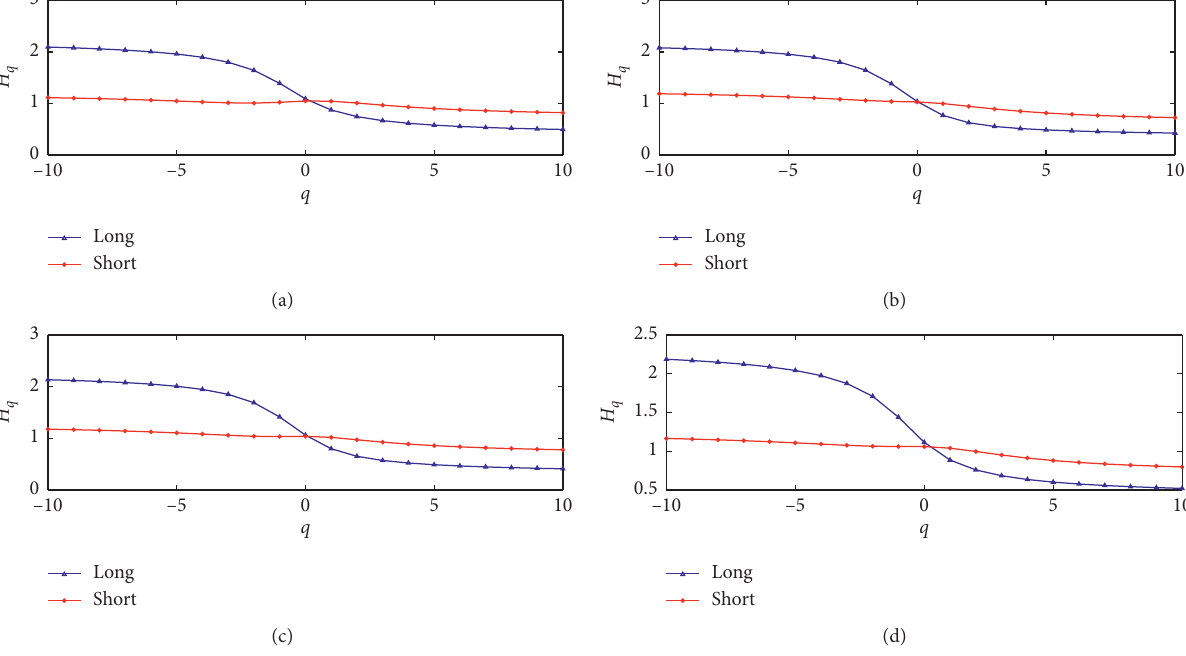
Figure 13: Short and long scaling exponents for Chinese stock market volatility and market participation willingness. (a) SME-YSI. (b) SSE50-YSI. (c) CSI300-YSI. (d)